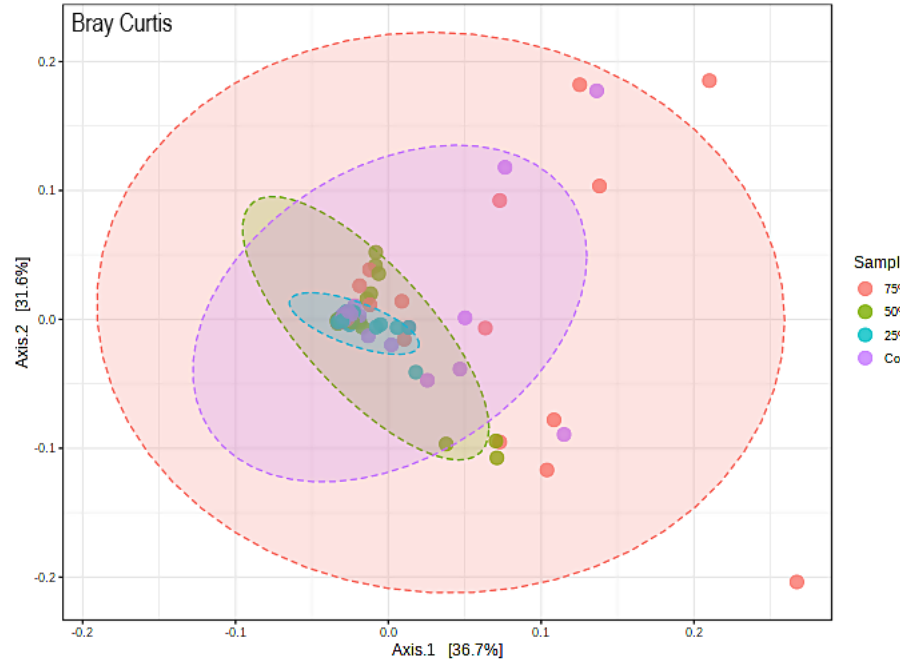
Figure 6. Beta diversity PCoA plot based on Bray-Curtis distance dissimilarity method between the different dietary treatments. PERMANOVA R ₋ Squared: 0.049; p ₋ value > 0.001.